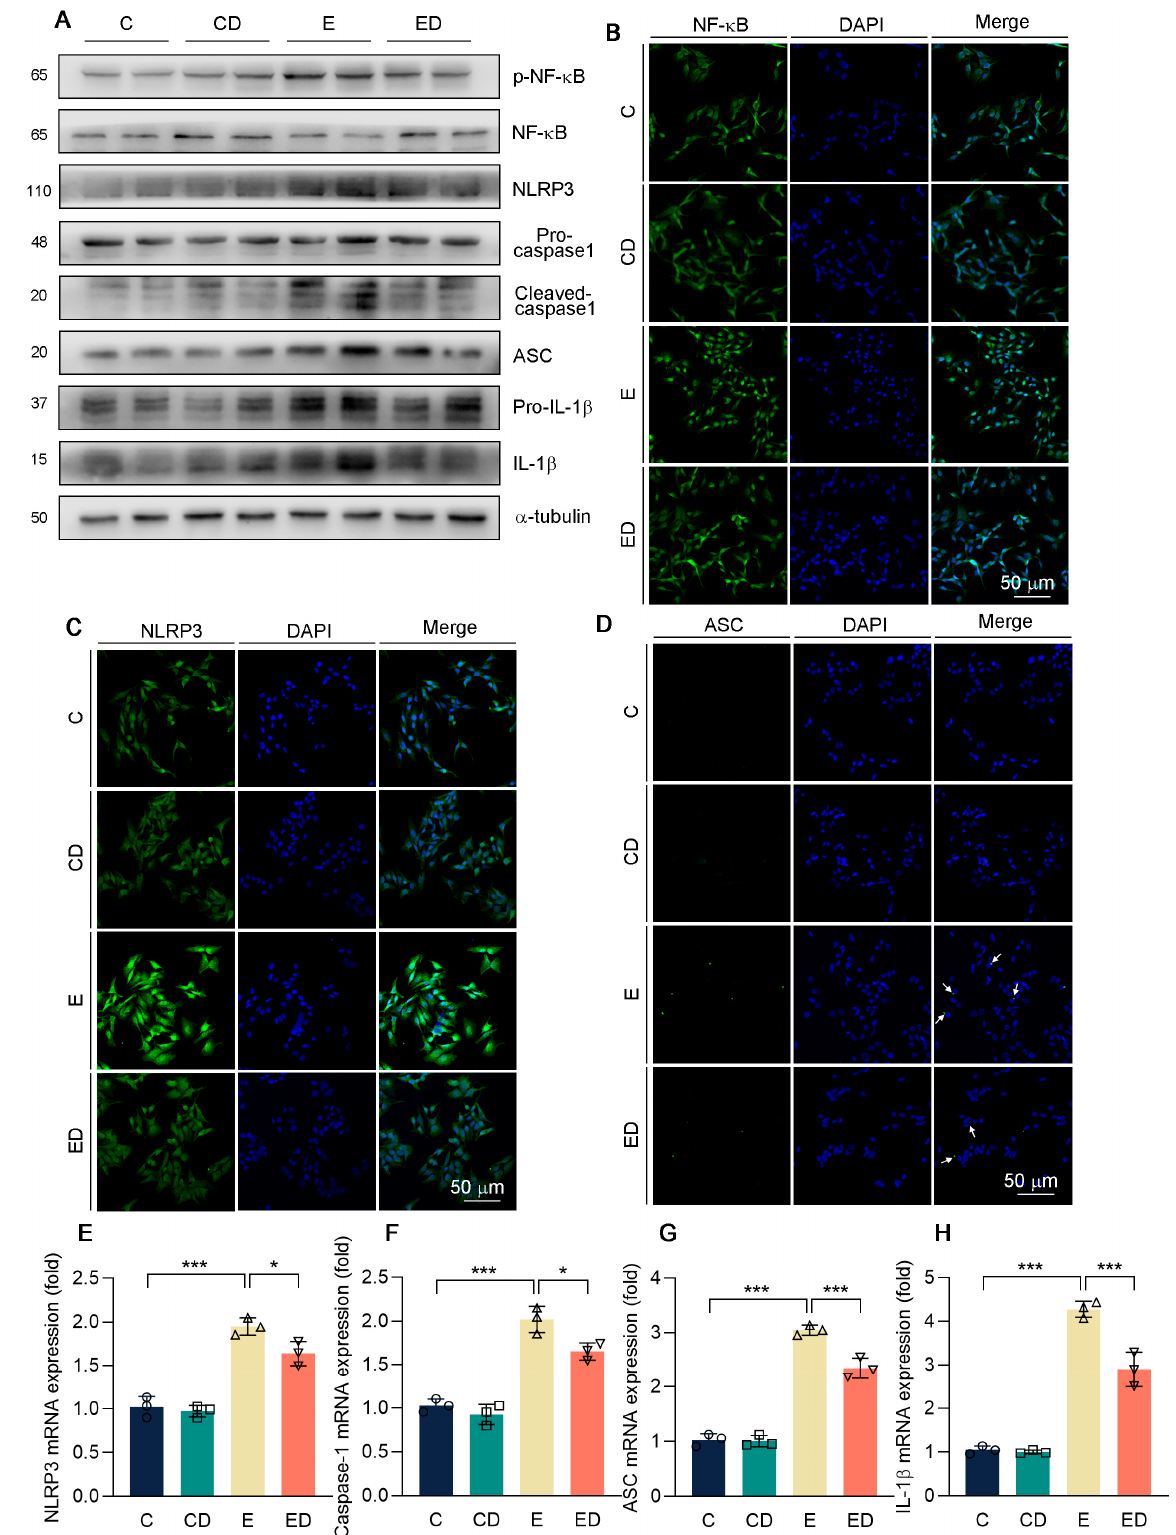
Figure 6. The effect of DAU on oxidative stress in HepG2 cells induced by alcohol. ( A ) Protein expression of p − NF − κ B, NF − κ B, NLRP3, pro − caspase − 1, cleaved − caspase1, ASC, pro − IL − 1 β and IL − 1 β in HepG2. ( B – D ) Immunofluorescent staining of NF − κ B, NLRP3, and ASC in HepG2. ( E – H ) mRNA expression of NLRP3, caspase − 1, ASC, and IL − 1 β in HepG2 cells. Data are mean ± SD using one − way ANOVA ( n ≥ 3), * p < 0.05, *** p <